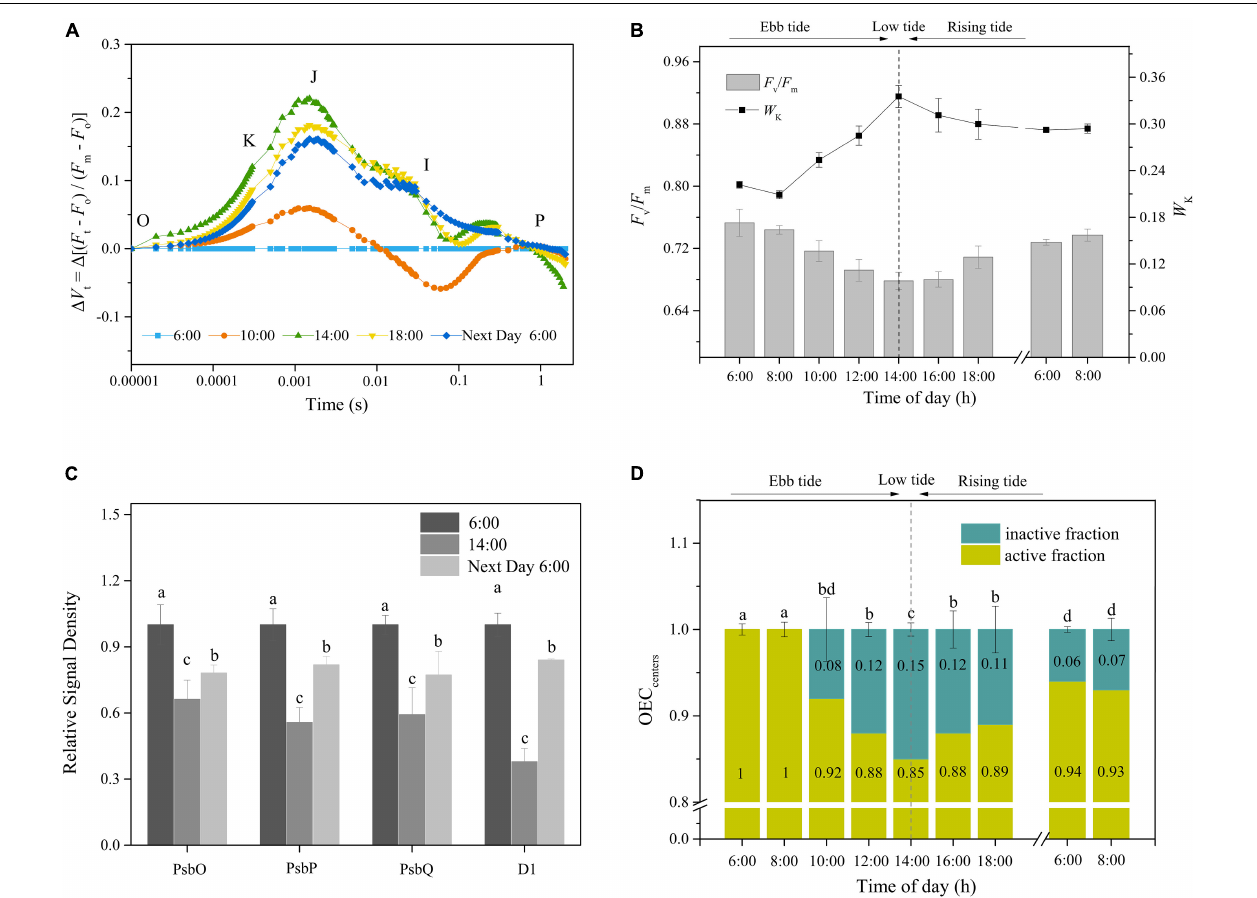
FIGURE 6 | The in situ occurrences of OEC photoinactivation. (A,B) Changes in the (cid:49) V t curves, F v / F m , and W K in response to the tidal cycle. (C) The relative protein expression levels of PsbO, PsbP, PsbQ, and D1 in the early morning, lowest tide, and after dark recovery overnight. The means ± SD were calculated from three independent samples. Different letters indicate a significant difference (Tukey’s tests, p < 0.05). (D) Time courses of OEC centers in response to the tidal cycle. Different letters indicate a significant difference (Tukey’s tests, p < 0.05). The photosynthetic photon flux density (PPFD) at 8:00, 10:00, 12:00, 14:00, and 16:00 was around 100, 250, 350, 400, and 300 µ mol photons/m 2 s, respectively. The means ± SD were calculated from three independent